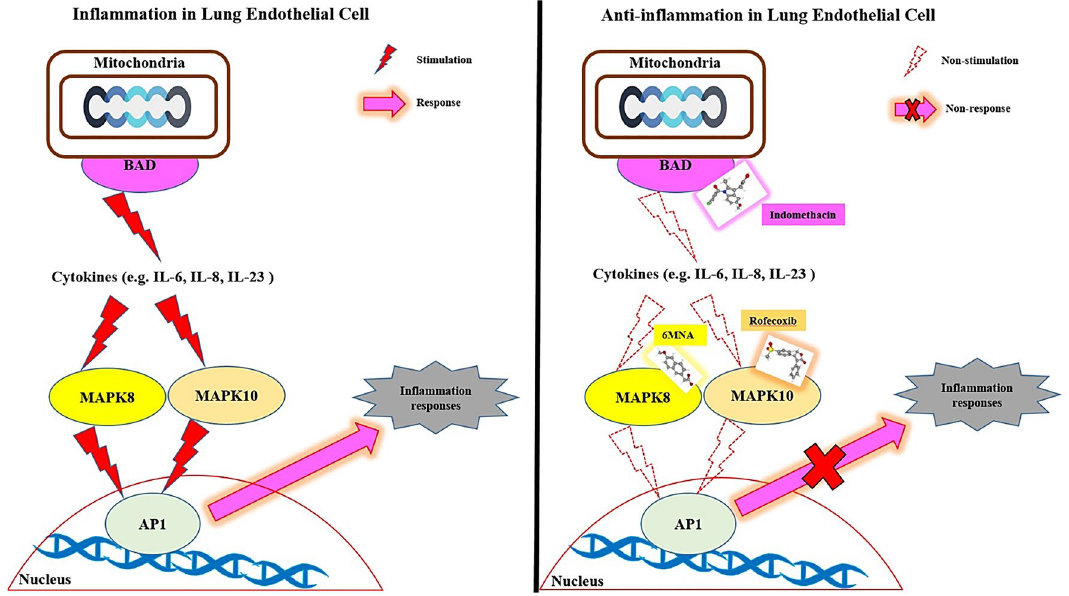
Figure 8. Anti-inflammation mechanisms of promising NSAIDs against